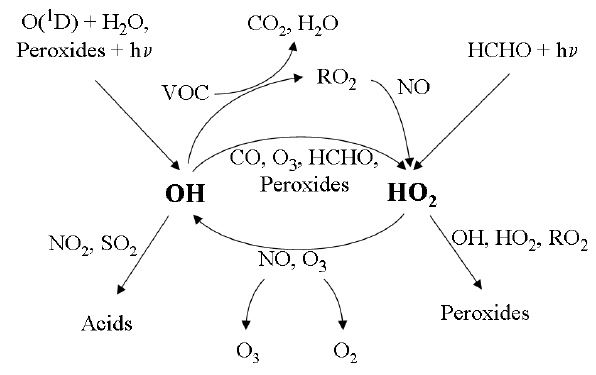
Fig. 13. Schematic representation of HO x cycling.